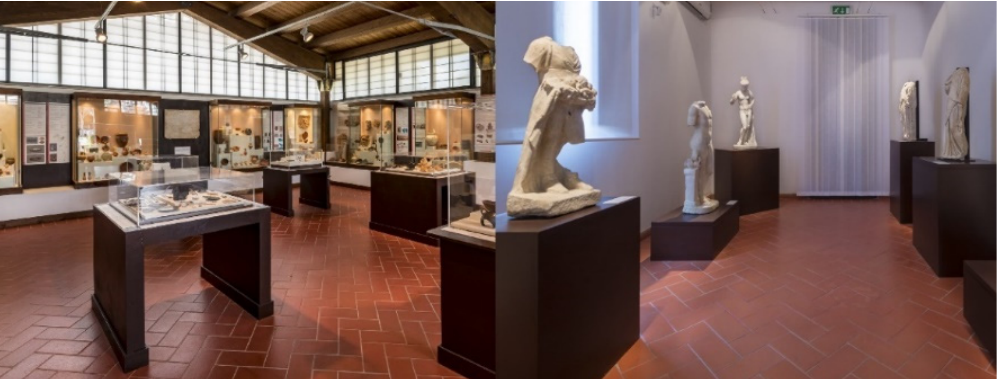
Figure 3. Internal view of Antiquarium of Lucrezia Romana. Source: Appia Antica Archaeological Park [76].